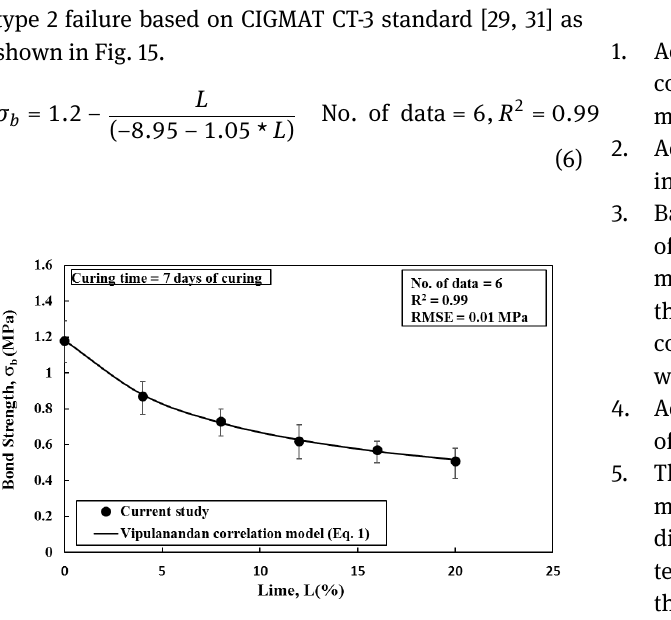
Figure 15: Typical tensile bonding failure for cement mortar modified with